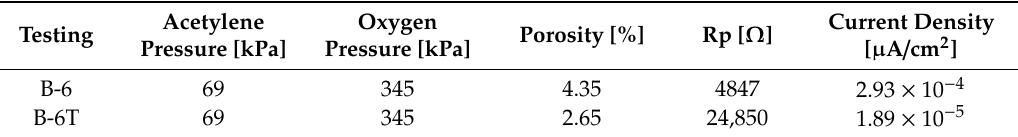
Table 3. Results of the potentiodynamic (current density) and EIS test (Rp) of the samples of coatings B-6 and B-6T without and with heat